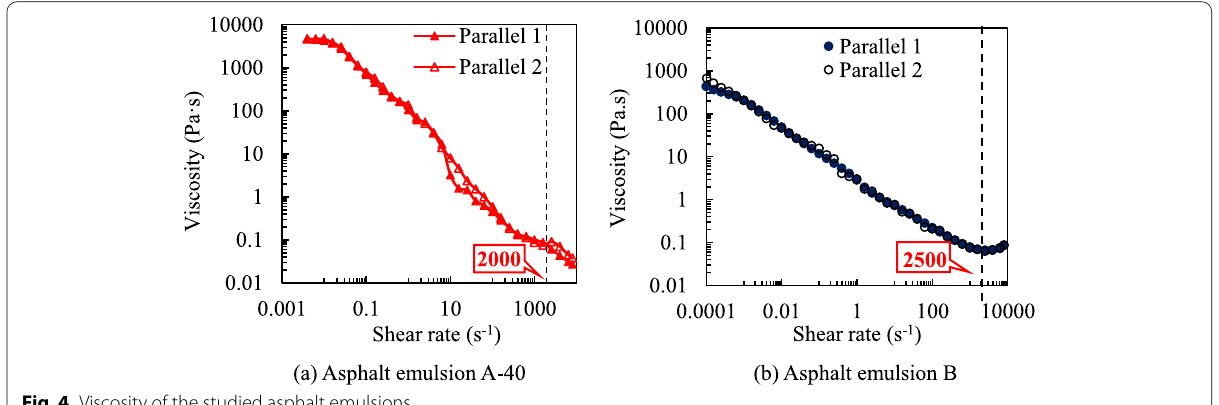
Fig. 4 Viscosity of the studied asphalt emulsions